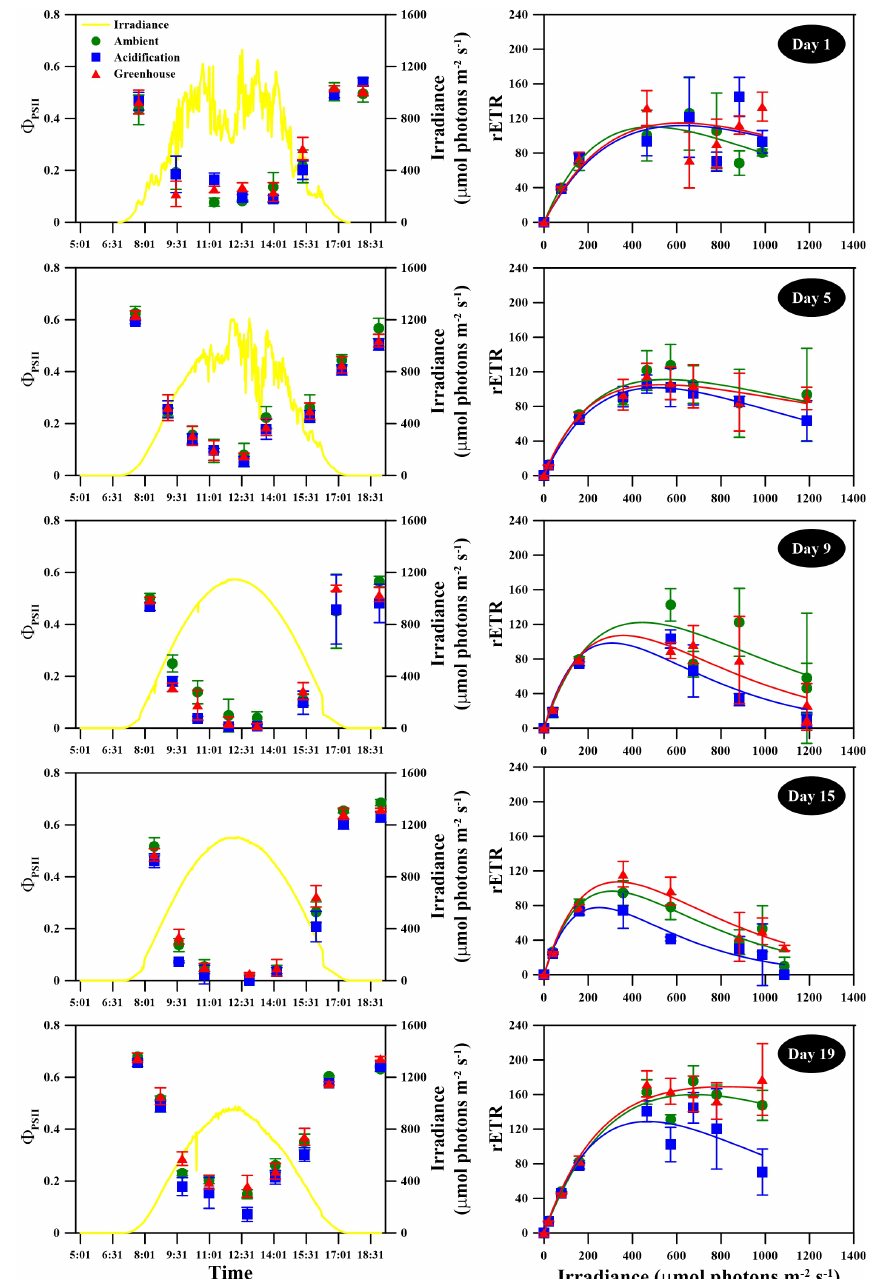
Fig. 2. Effective quantum yield of PSII ( 8 PSII , left column), and steady-state light response curves (rETR-I curves (LCs), right column) of the phytoplankton community during the experimental period under the ambient (green), acidification (blue), and greenhouse (red) treatment conditions. Error bars represent the standard deviation from the mean of replicate enclosures ( n = 3).